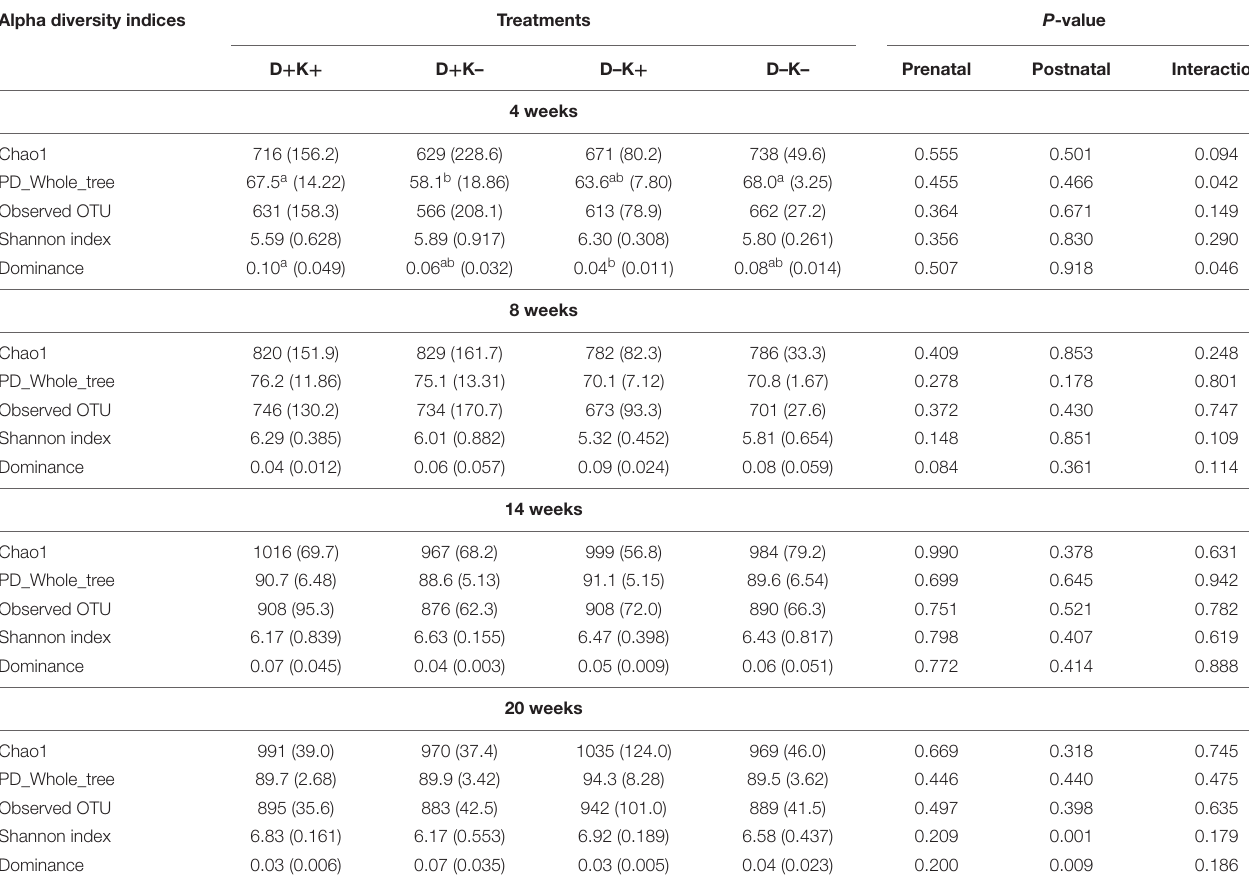
TABLE 1 | Mean (standard deviation) of α -diversity indices (Chao1, PD_Whole_tree, Observed OTU, Shannon index and dominance) characterizing the rumen bacterial community structure of goat kids at 4, 8, 14, and 20 weeks of age. Alpha diversity